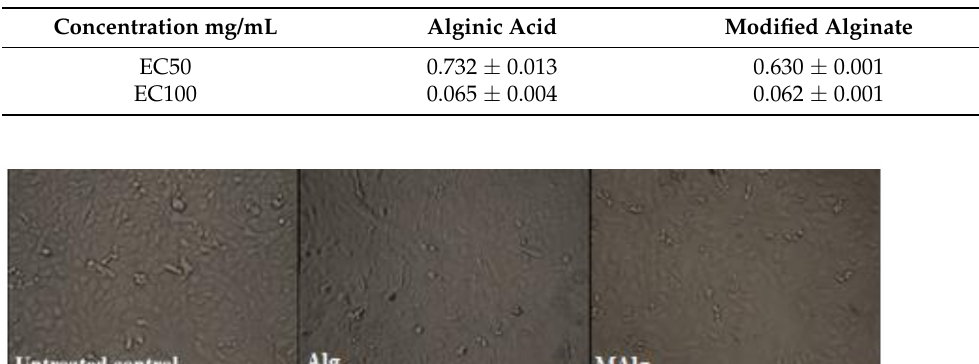
Table 3. Effective concentrations (mg/mL) of alginate and aromatic alginate derivative at 50% and 100% Wi-38 viability.